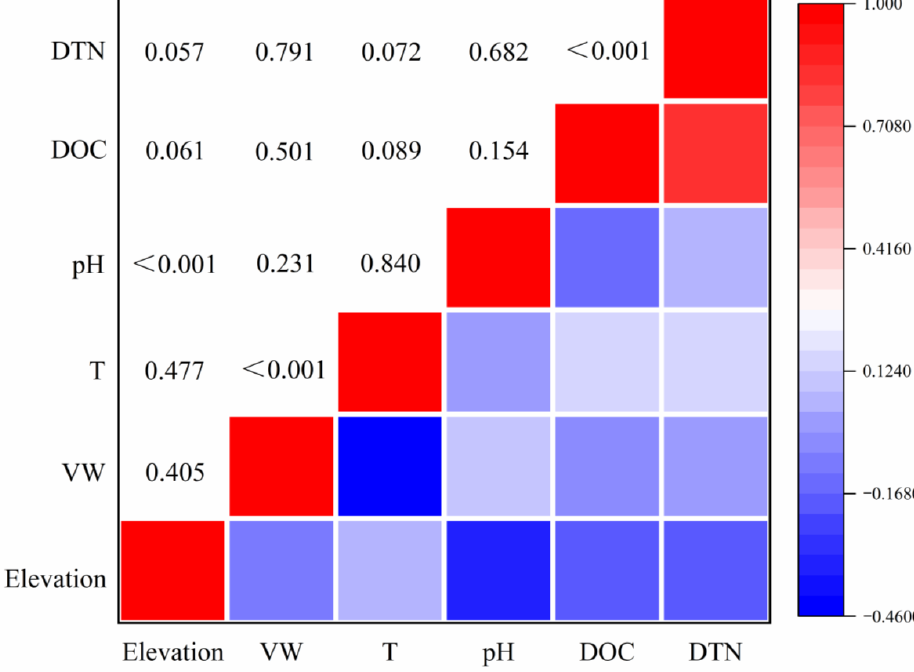
Figure 4. Correlation matrix (with individual p values shown in the upper left of the panel)